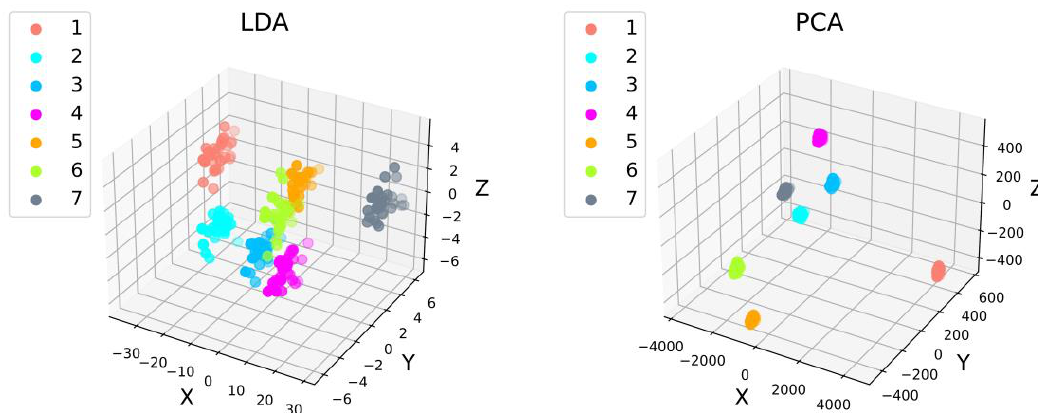
Figure 2. LDA and PCA dimensionality reduction.